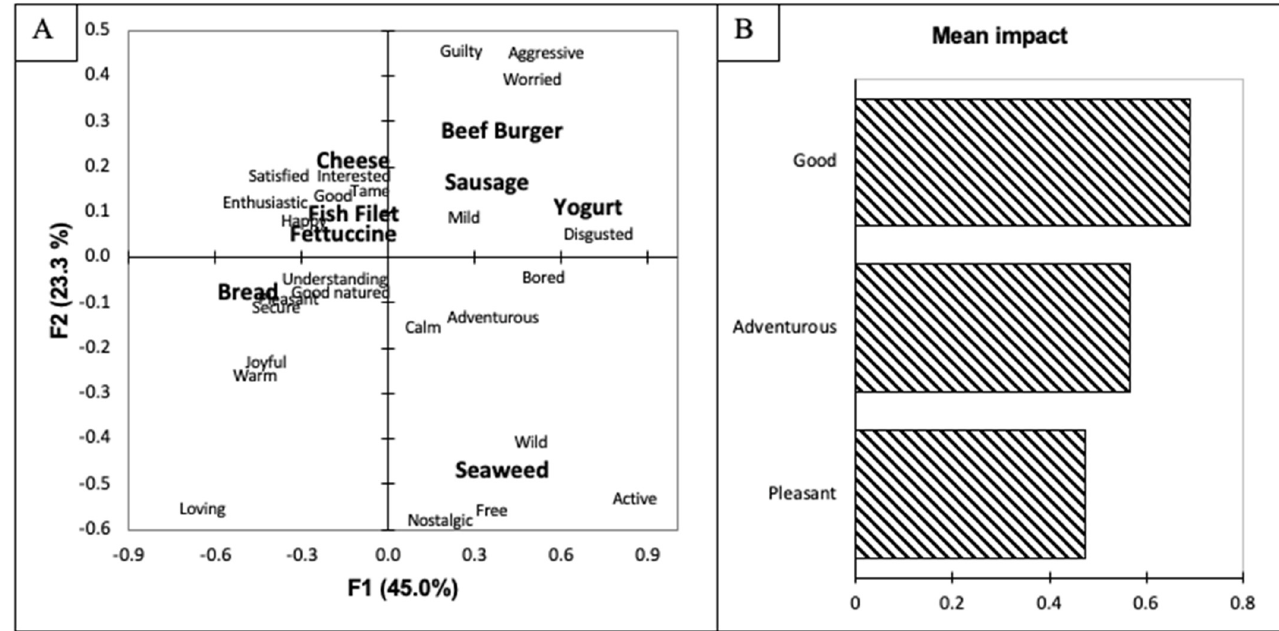
Figure 1. ( A ) Biplot representation of the seaweed-containing food items and emotional terms on the first two dimensions of the correspondence analysis for the overall population. ( B ) Penalty lift analysis of the emotional terms and willingness to pay based on the overall population’s evaluation of the seaweed-containing food items.